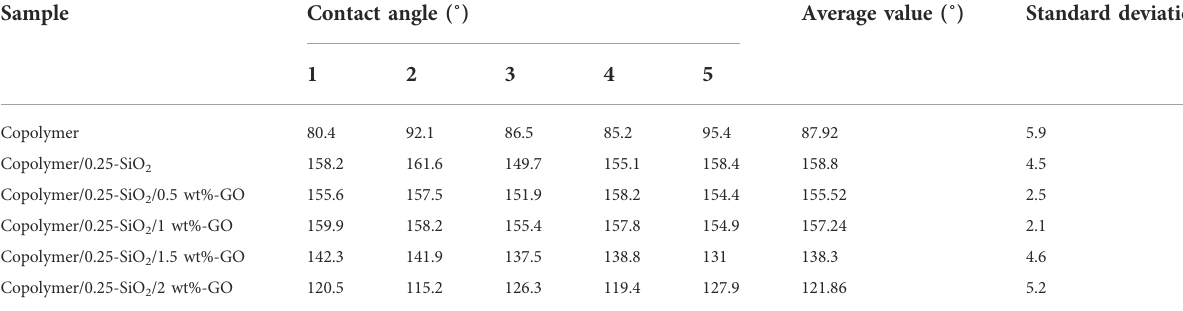
TABLE 1 WCAs of composite coatings with 0.25 g SiO 2 NPs and different GO contents. Sample